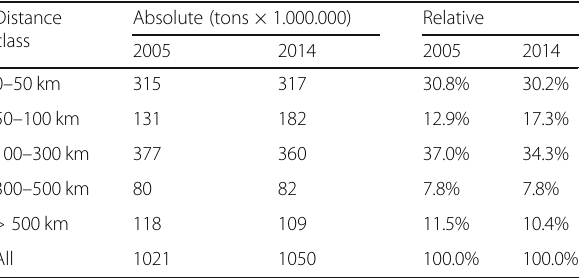
Table 4 Size of the distance markets in tons (including those in